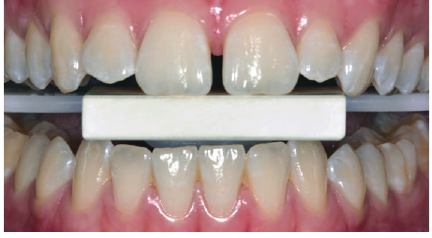
Figure 4: Final picture taken with calibration